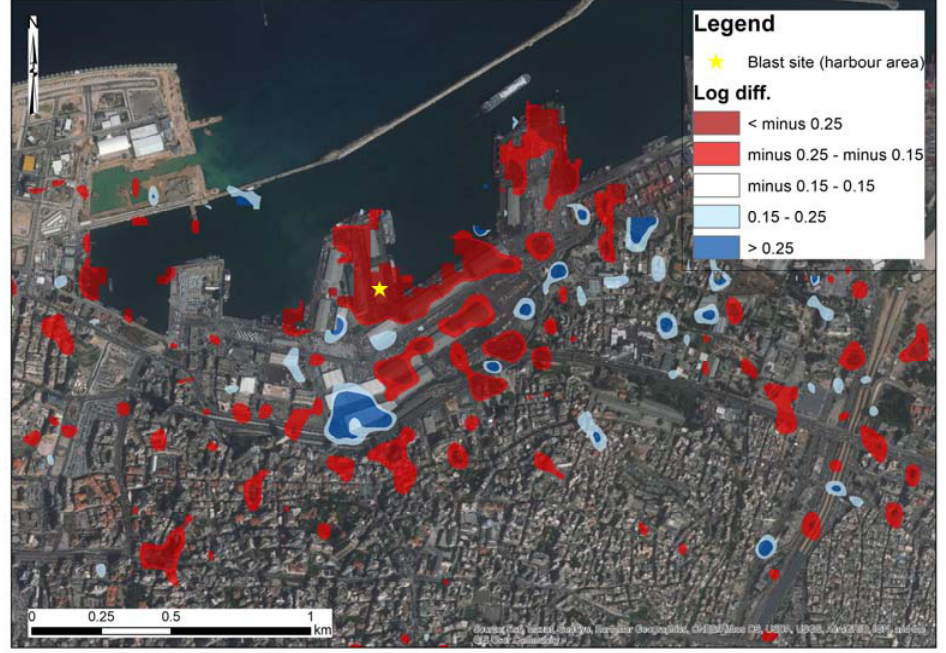
Figure A4. Change detection results—as in Figure A2, see before—for the area around the blast site near the harbor of Beirut (indicated with a white dashed line in Figure A2). The location of the blast size is shown with the yellow star.